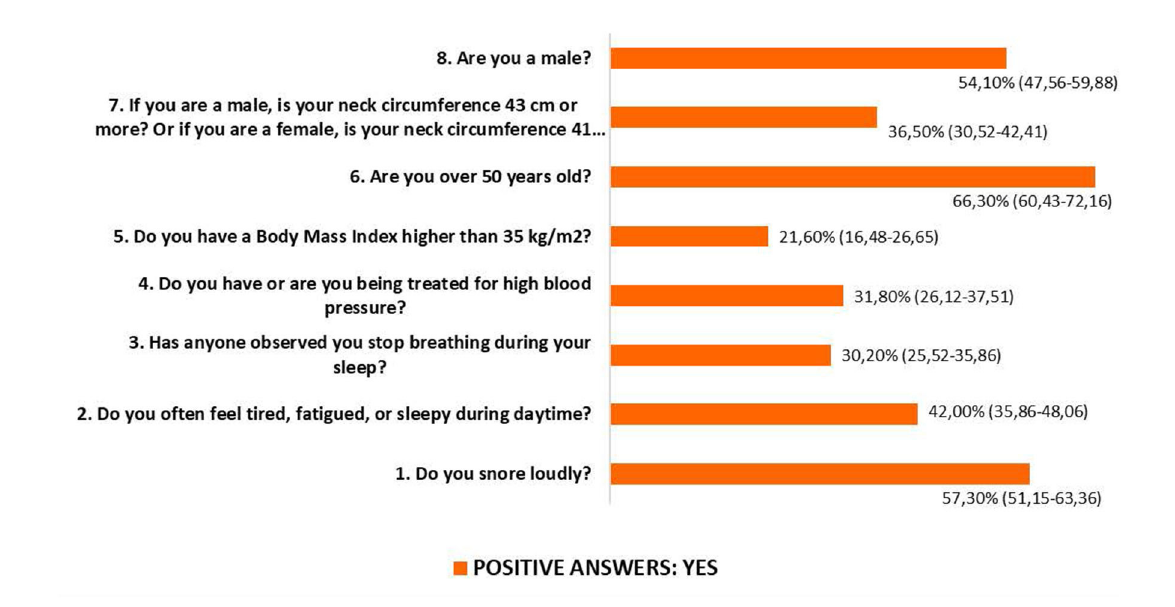
FIGURE1 STOP-Bang results. Population parameters with a 95% confidence level. Item 1: YES 44.4% (95% CI: 35.30–53.58) of women and 68.1% (95% CI: 60.24–75.98) of men ( p < 0.021). Item 2: YES 41% (95% CI: 31.98–50.07) of women and 42.8% (95% CI: 34.39–51.11) of men ( p = 0.010). Item 3: YES 14.5% (95% CI: 8.04–21.01) of women and 43.5% (95% CI: 35.10–51.85) of men ( p < 0.001). Item 4: YES 25.6% (95% CI: 17.61–33.67) of women and 37% (95% CI: 28.80–45.11) of men ( p < 0.001). Item 5: YES 15.4% (95% CI: 8.74–22.01) of women and 26.8% (95% CI: 19.27–34.29) of men ( p < 0.001). Item 6: YES 65.8% (95% CI: 57.08–74.53) of women and 66.7% (95% CI: 58.70–74.63) of men ( p < 0.001). Item 7: YES 6.8% (95% CI: 2.19–11.47) of women and 61.6% (95% CI: 53.37–69.81) of men ( p < 0.001). Total sample n = 255 (117[45.9%] women and 138 [54.1%] men), Pearson’s Chi-square contrast